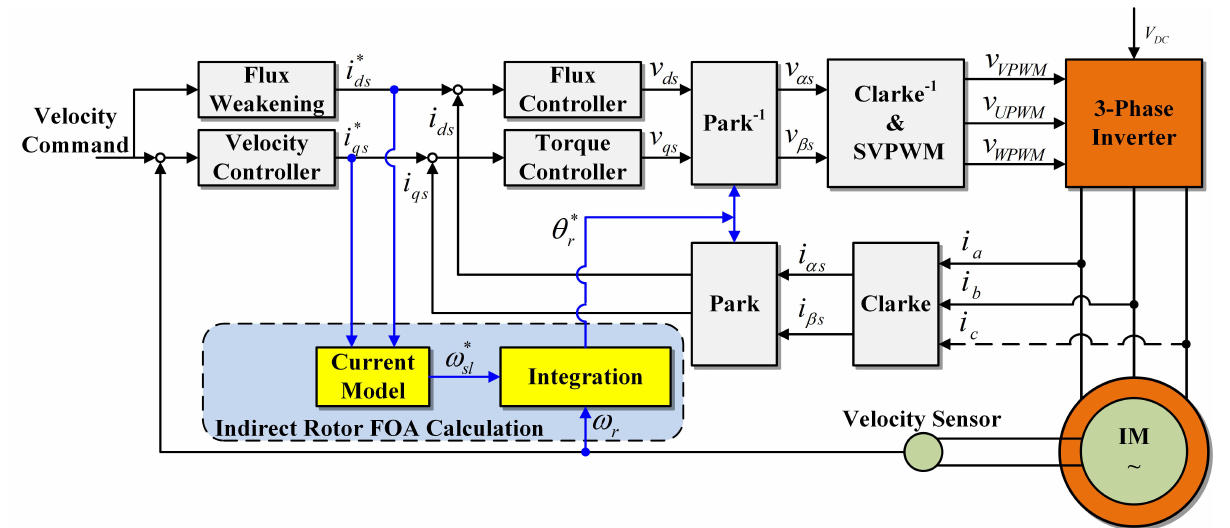
Figure 1. Control diagram of induction machine